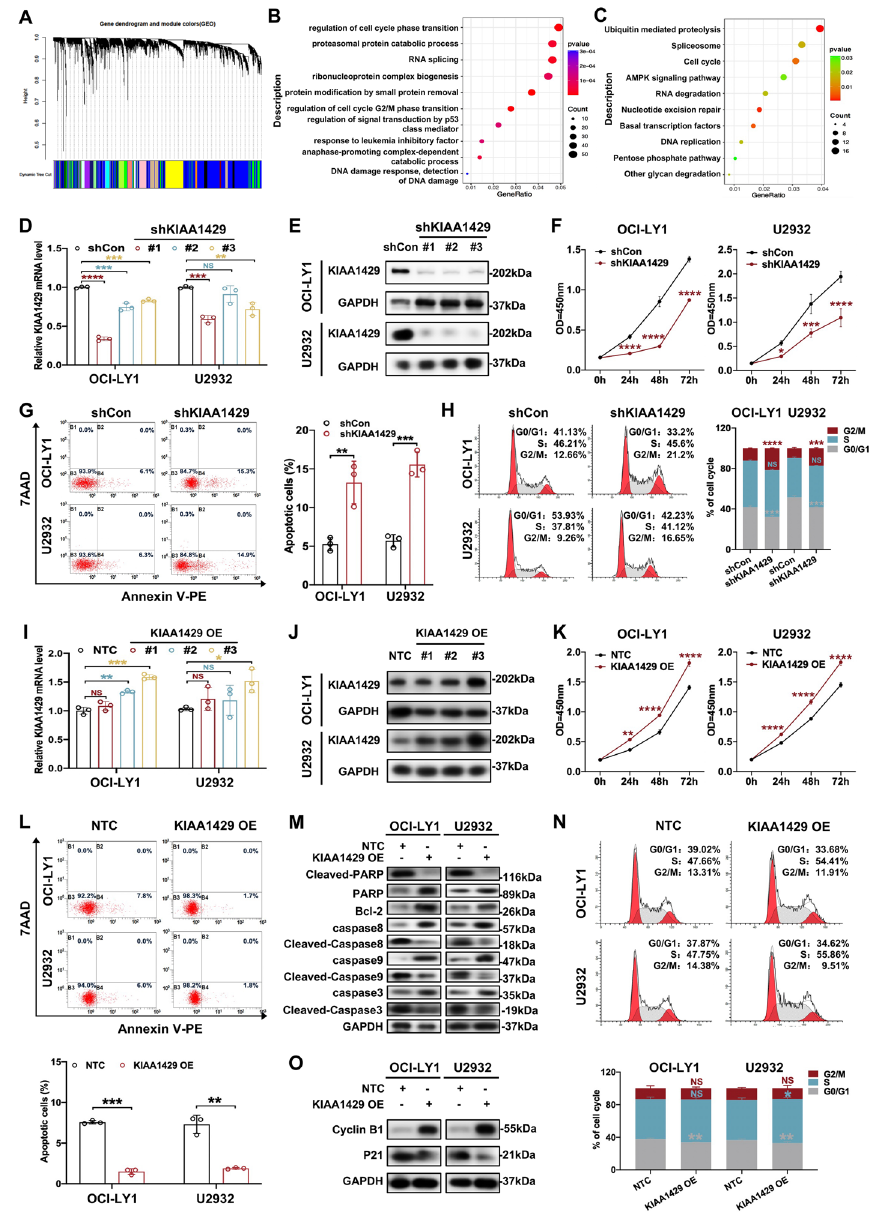
Fig. 2 (See legend on previous